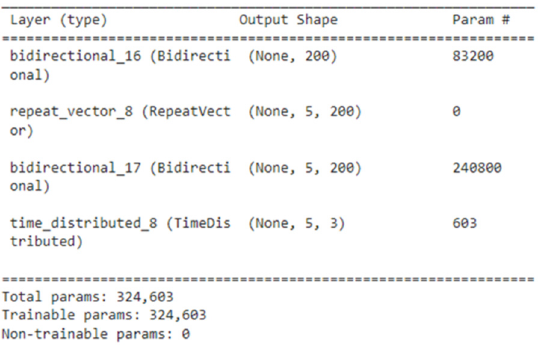
Figure 9. Summary of trained model (whose coding given in Figure 8).